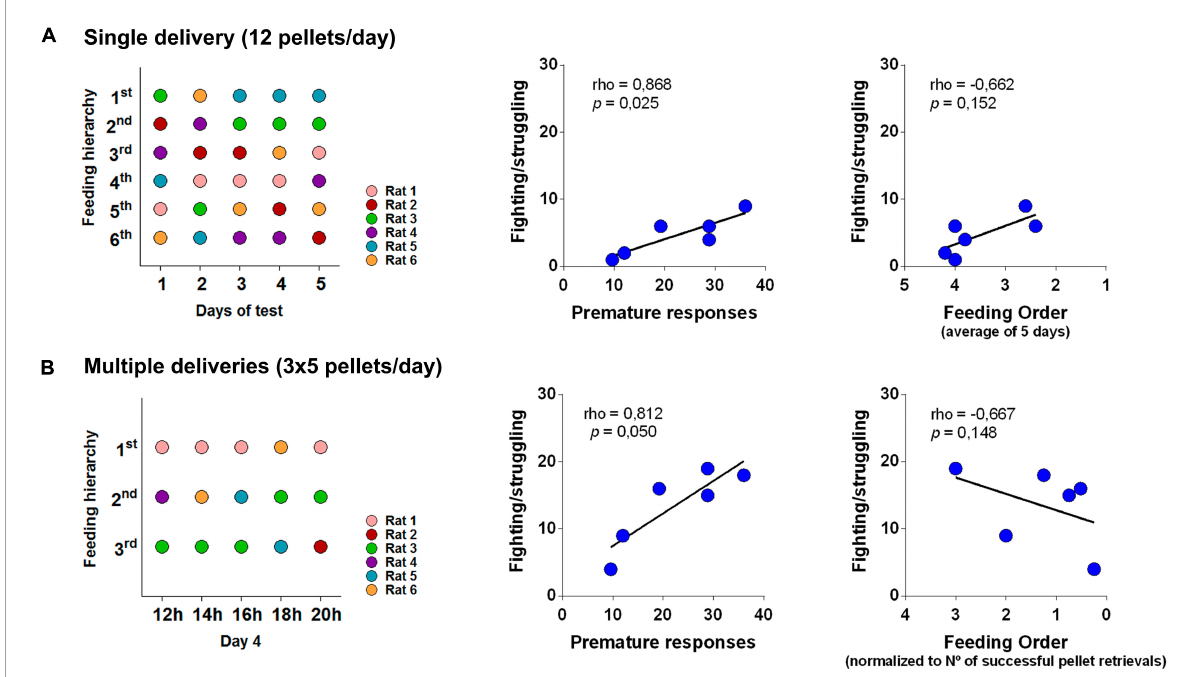
FIGURE4 Fighting/struggling correlates with external measures of impulsive behavior. (A,B) Feeding hierarchy was determined as the order by which rats reached and grabbed their first food pellet upon delivery by the automatic motorized feeder in each day of the test (s.d.) or in each deliver of the 4th day (m.d.). (A) Feeding ranks in s.d. were calculated as the average of the order of pellet retrieval in the 5 days of the experiment; in m.d. (B) feeding ranks were calculated as the average of the order of pellet retrieval/No of successful pellet retrievals ratio. In both conditions, the counting of behavioral displays of fighting/struggling positively correlated with impulsive behavior assessed by the variable delay-to-signal (VDS) test. No relation was found between this behavioral display and feeding hierarchy. The Spearman’s correlation test was used to perform the analysis and p -value (two-tailed). Correlation was considered significant for p < 0.05, n =